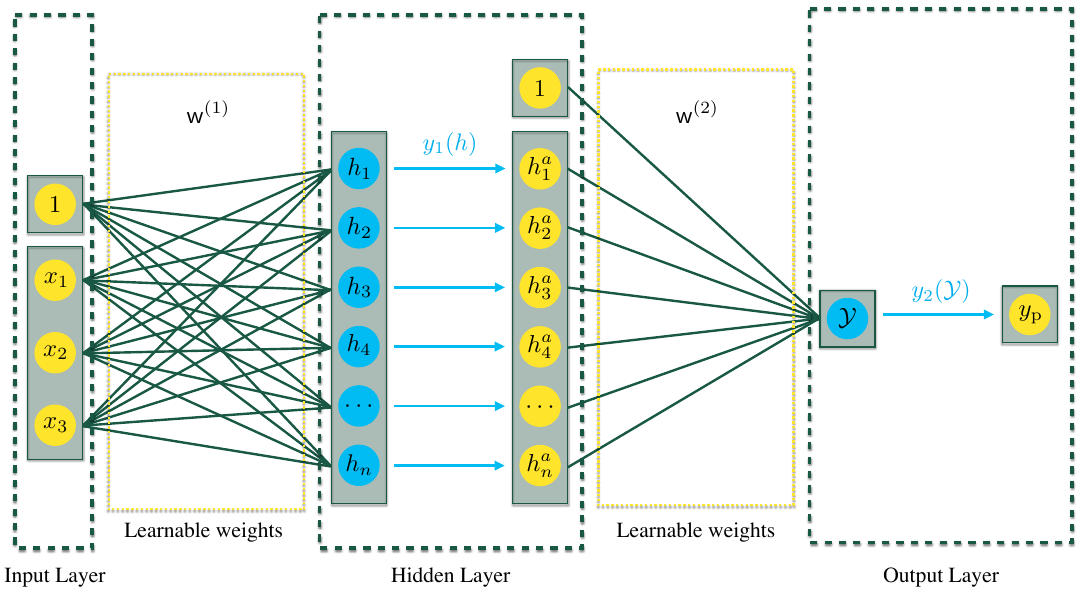
Figure 1 . A schematic representation of a network with three layers (one hidden), such as the networks used in this paper. Each of the layers is marked by a dashed green box. All of the yellow circles represent a real number (node). The green lines are the connections between nodes and are each learnable parameters. The light blue arrows map the node activity (number in blue) to the node by applying the activation